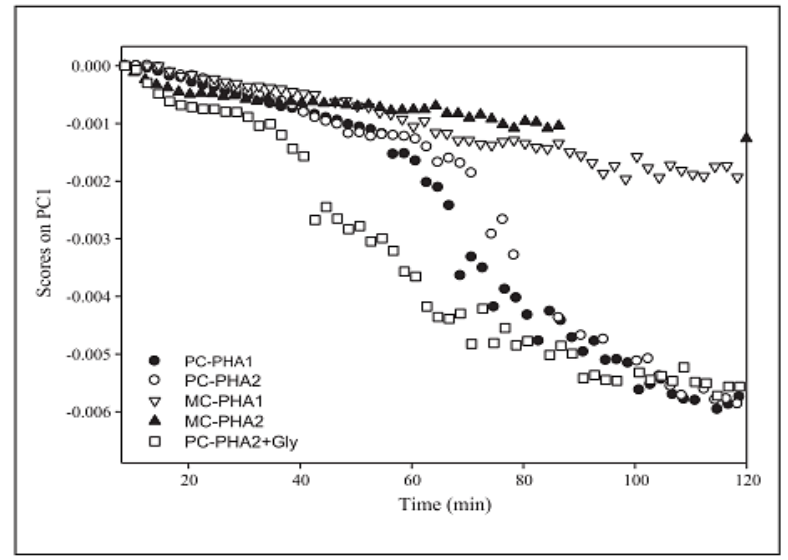
Figure 4. PC1 scores plot with time. (Reproduced with permission from Montano Herrera et al., new biotechnology; published by Elsevier, 2013) [37].